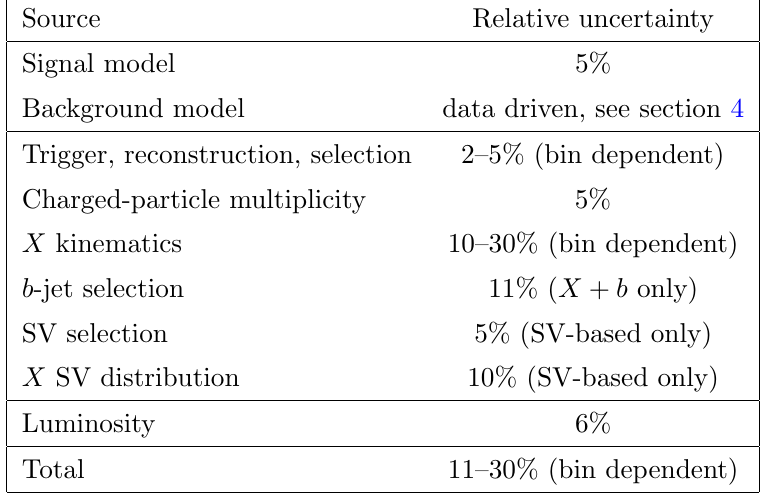
Table 2 . Summary of systematic uncertainties. The luminosity and e(cid:14)ciency uncertainties are highly correlated, which is accounted for when obtaining the total uncertainties.